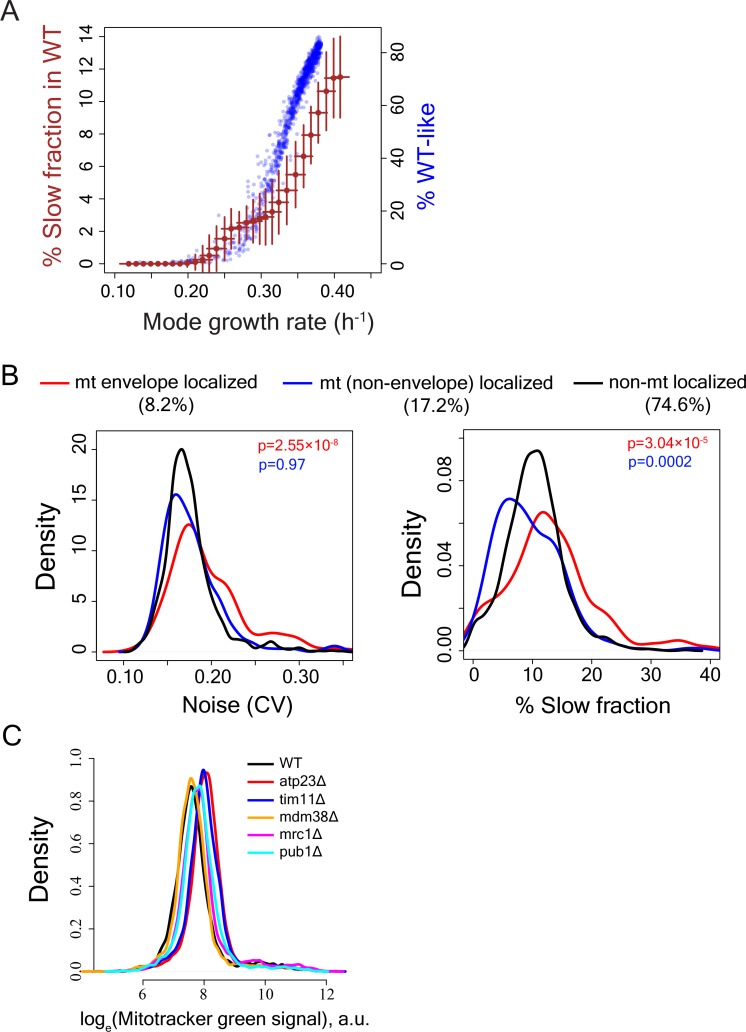
Calculation of slow-growing sub-population and functional enrichment analysis.(A) To test how reduction in mode growth rate without any change in growth rate of slow sub-population might influence our capability to detect slow fraction, the main sub-population of WT strain was computationally moved by reducing mode growth rate in steps of 0.01 h−1 without altering the growth rate of the slow sub-population. This was done for all independent measurements of growth rate distributions for WT. The brown points show average value for all such independent computations and the error bars show ±1 s.d. values from all computations. The blue points show the %WT-like cells vs. mode growth rate (h−1) for mutants exhibiting incomplete penetrance (IP). A mutant was considered to be incompletely penetrant if its proliferation distribution had significant overlap with the bulk of the WT proliferation distribution. (B) Distribution of Noise (Coefficient of variation or CV) (left) and distribution of percentage slow fraction (right) for knock-out of genes that localize to mitochondrial envelope (in red), genes that localize to mitochondria (excluding mitochondrial envelope) (blue) and rest of the genes (black) in our dataset. P-value in red is from statistical test between red and black distributions and P-value in blue is from statistical test between blue and black distributions (Mann-Whitney U test). (C) Mitochondrial amount of WT and mutant strains as measured by Mitotracker green intensity using flow cytometry.